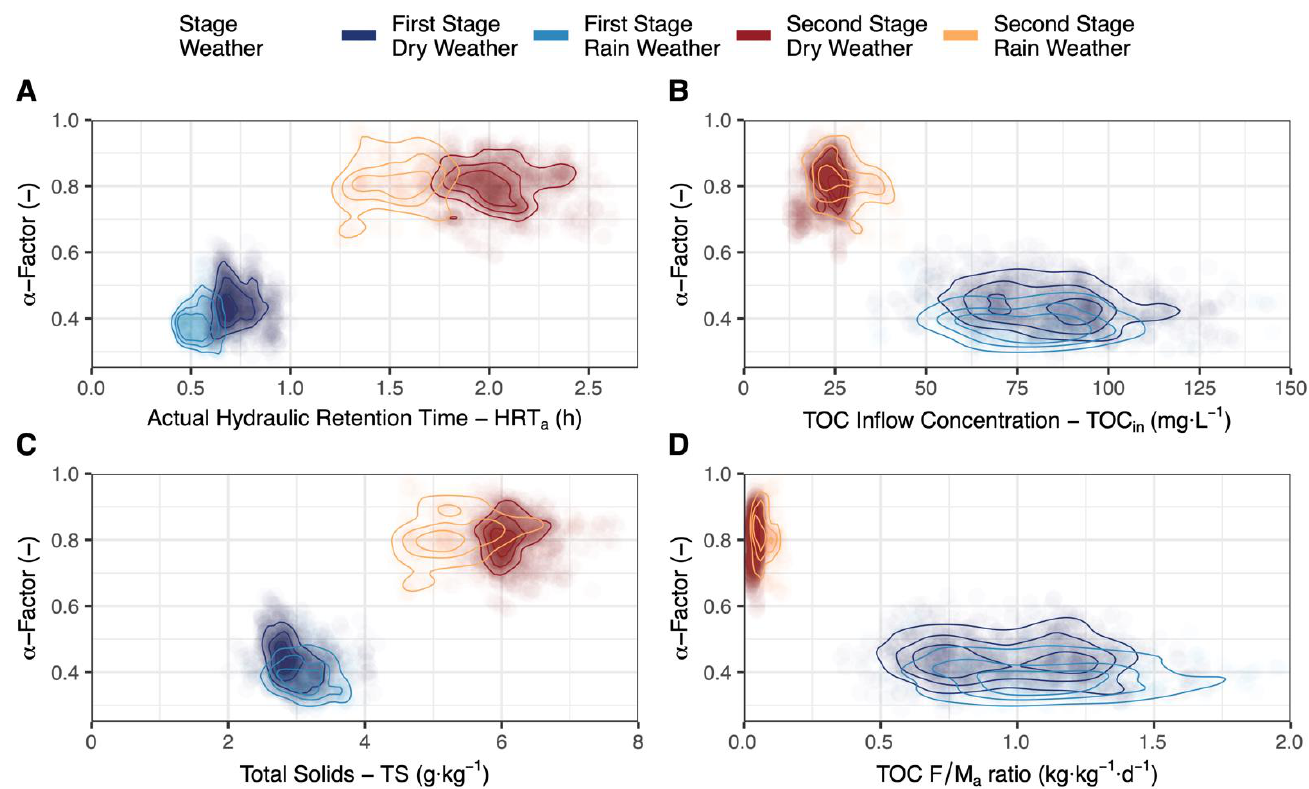
Figure 4. The α -factors for HRT a ( A ), TOC in ( B ) TS ( C ), and the aggregated parameter TOC F/M a ratio ( D ) grouped for treatment stages of a two-stage WWTP and weather conditions.